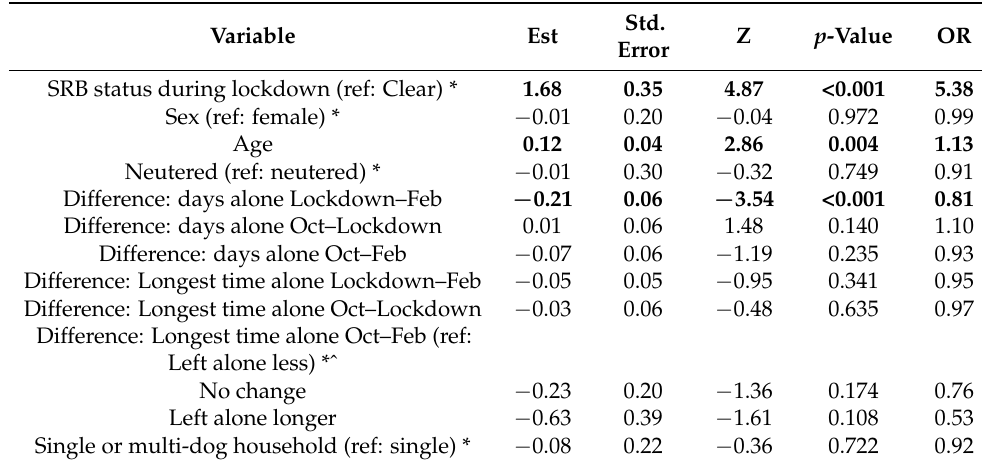
Table 1. Results from univariable logistic regression models for n = 1407 dogs who were Clear of SRB signs in February 2020. The dependent variable is SRB status in October 2020, of which n = 1070 were classified as still Clear in October, but n = 117 had transitioned to being SRB+ and n = 220 were not being left in October, so had a missing SRB status and were excluded from this analysis. Text in bold highlights variables significant to p < 0.05. * Denotes variables treated as categorical. Unless otherwise indicated, variables were treated as